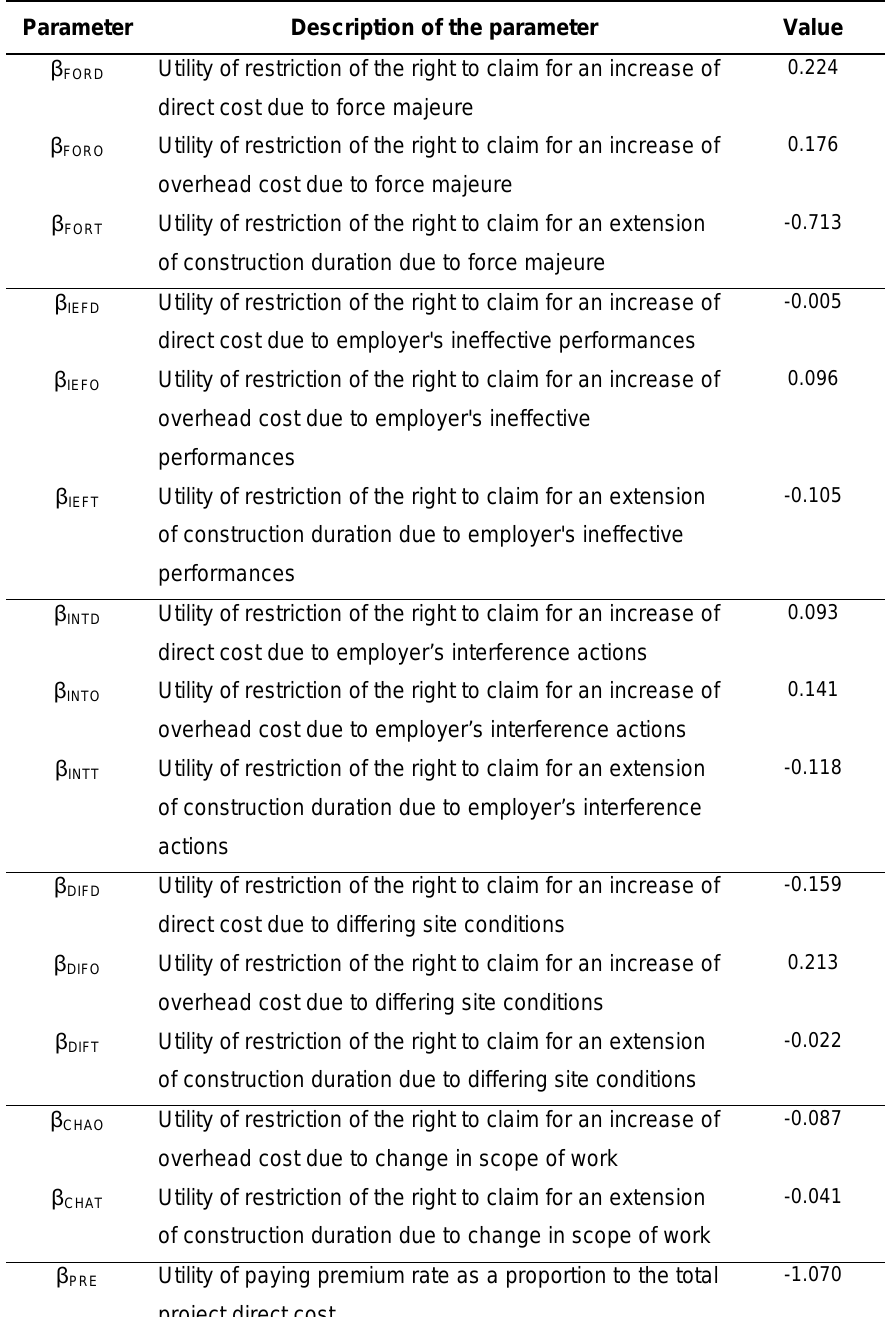
Table 3: Value of each utility parameter related to the restriction of the contractor’s right to claim for compensation and the premium